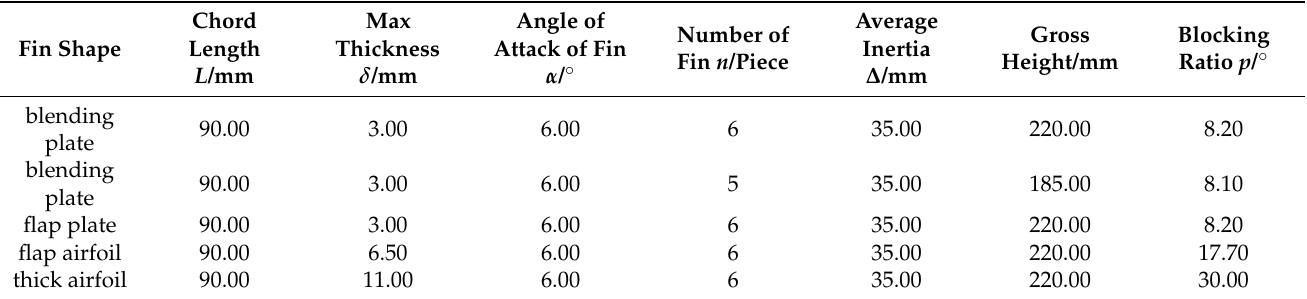
Figure 12. CAD model of different shutters with distinct fin shape. ( a ) Shutters with blending plate fin ( n = 6, with leading edge fin, explained in the next paragraph). ( b ) Shutters with blending plate fin ( n = 5, without leading edge fin). ( c ) Shutters with flap airfoil (BABIC) fin. ( d ) Shutters with flap plate fin. ( e ) Shutters with thick airfoil (ch10) fin. Table 2. Corresponding parameters in the simulation of fin shape optimization.